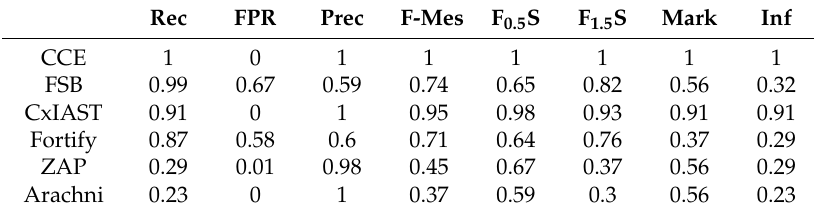
Table 3. Metrics applied to individual tools.